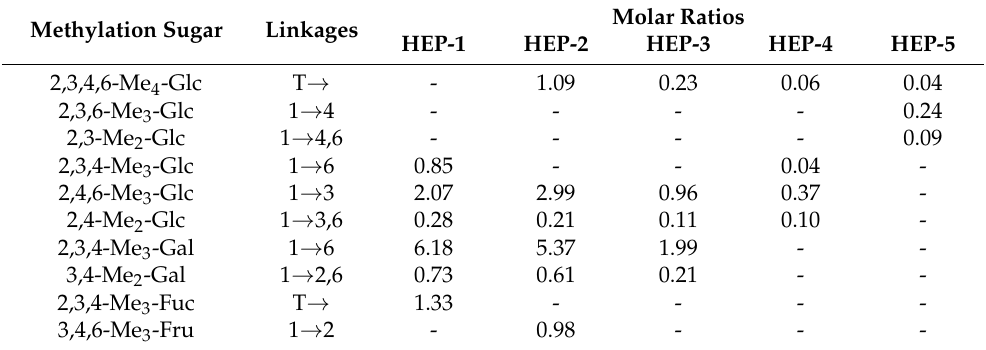
Table 2. GC-MS results of methylation analyses of polysaccharides HEP-1, HEP-2, HEP-3, HEP-4 and HEP-5. Molar Ratios Linkages HEP-1 HEP-2